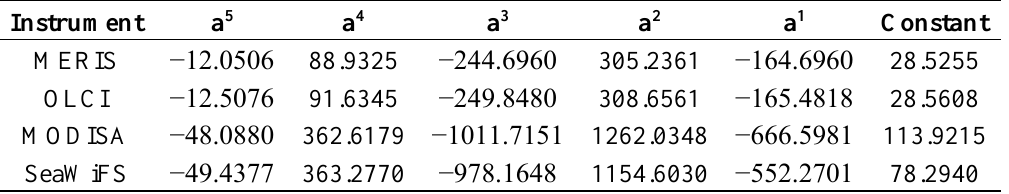
Table 4 . Polynomial coefficients to correct each instrument. a is the hue angle divided by